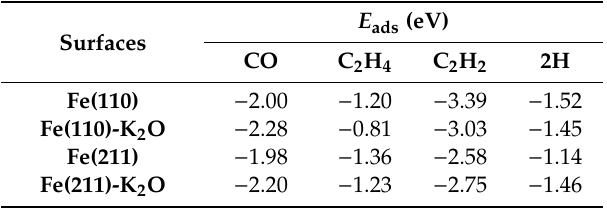
Table 1. The adsorption energies ( E ads , eV) of the most stable C 2 H 4 , C 2 H 2 , CO and H 2 on the Fe(110), Fe(110)-K 2 O, Fe(211) and Fe(211)-K 2 O surfaces.